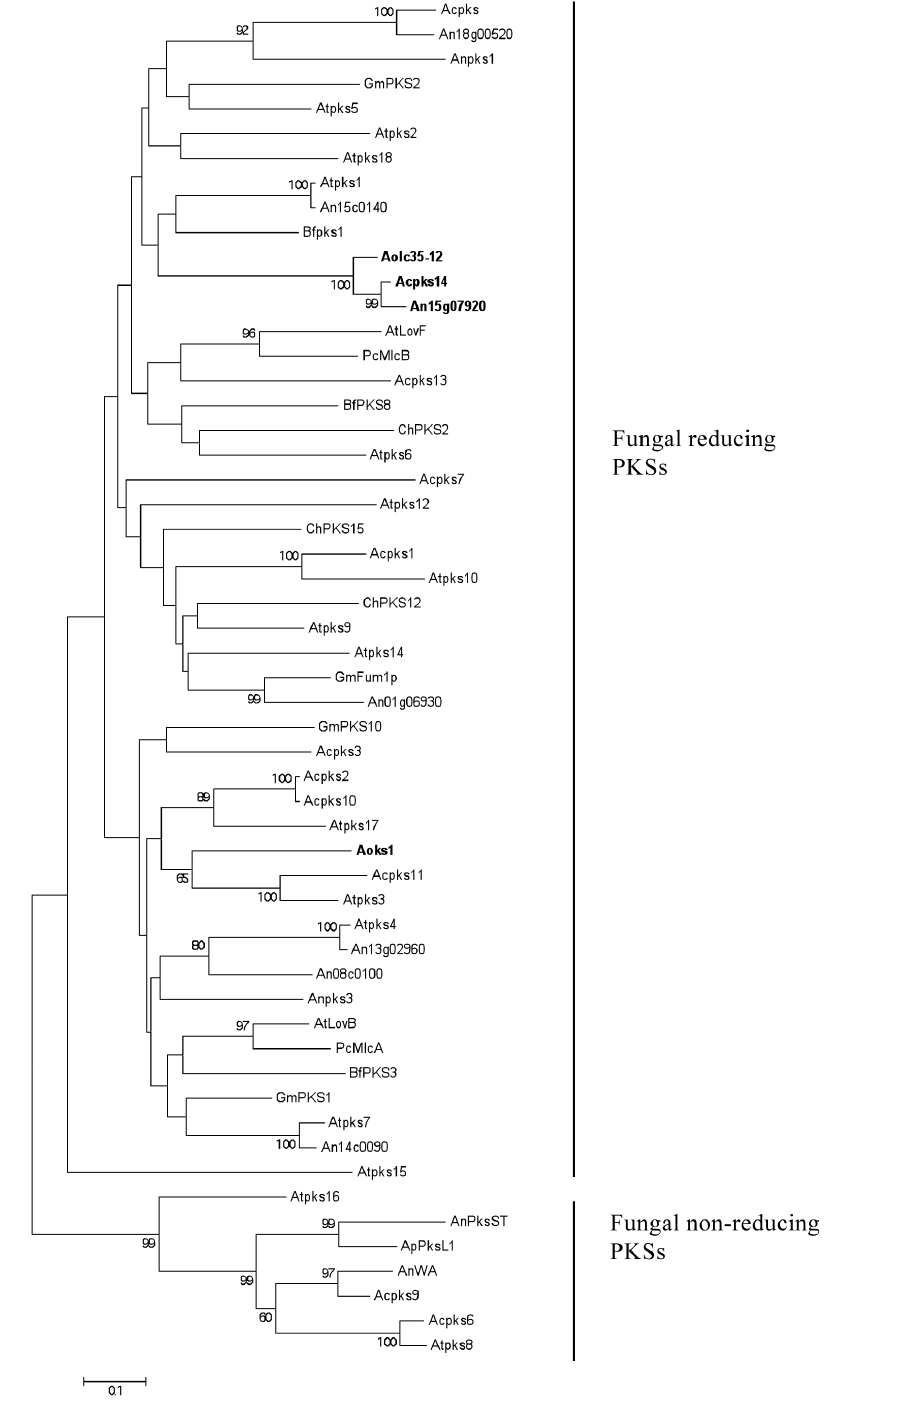
Figure 2. Neighbour-Joining phylogenetic tree (bootstrap analysis conducted using 1,000 replicates) of deduced ami- no acid sequences of PKS gene fragments identified in black aspergilli in grapes and fragments of fungal non-redu- cing and reducing reference PKS (from NCBI database). Only bootstrap values ≥50% are